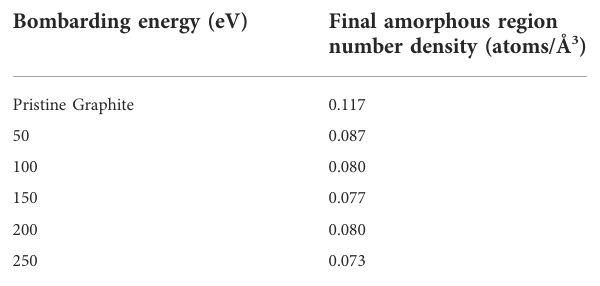
TABLE 1 Number densities of the original graphite block before bombardmentandofthe fi nalamorphousregionsforeachenergy tested.